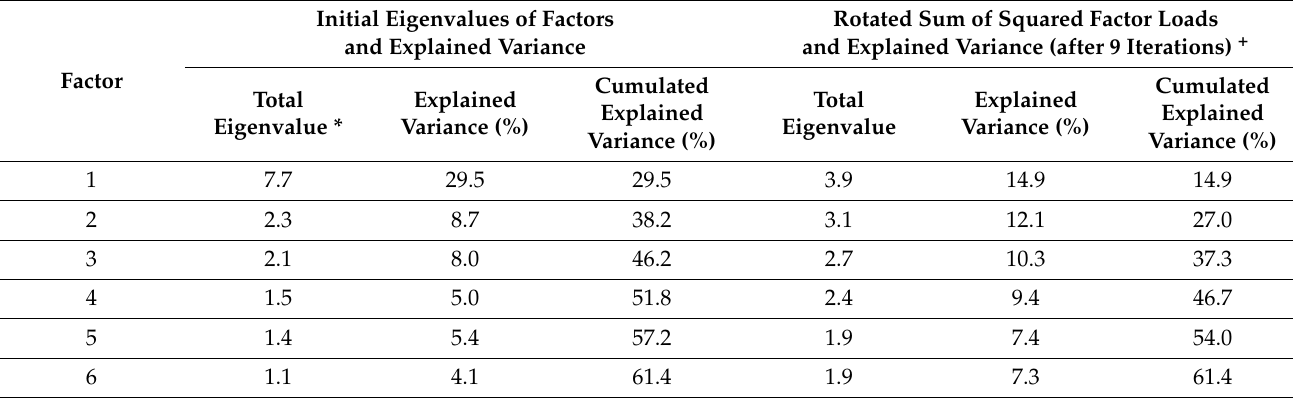
Table 3. Total variance explained by the six extracted factors (based on n = 222 questionnaires).